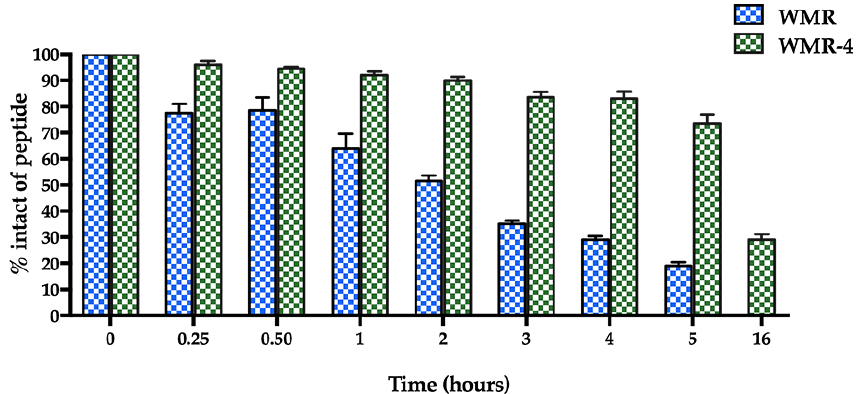
Figure 2. The serum stability of peptides WMR and WMR-4 in bovine serum determined by RP- HPLC. The percentage of intact peptide was obtained by calculating the relative peak area monitored by RP-HPLC and subtracting background peak areas in blank matrix.